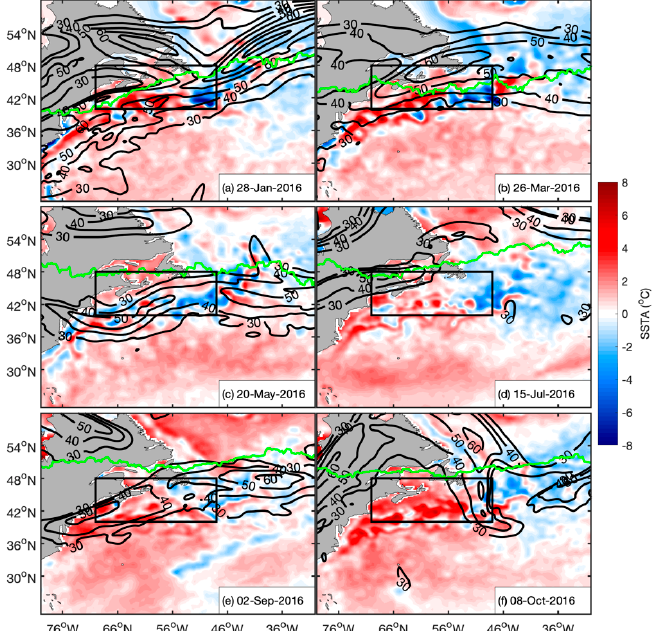
Figure 2. Spatial map of SSTA (°C) in the NW Atlantic throughout 2016. Black contour lines indicate wind speeds (m/s) at 300 hPa and the location of the Jet Stream. Green lines show the mean Jet Stream position based on the daily wind speed at 300 hPa from 1981–2020. Time series data was averaged over 40–48°N and 70–68°W indicated by the box. The 2016 MHWs were much less intense than the 2012 events. SSTAs were stronger in the earlier parts of the year (Figure 2a, average = 0.65 °C; Figure 2b, average = 0.32 °C) and later months (Figure 2e, average = 0.75 °C; Figure 2f, average = 1.62 °C). Positive SSTAs were contained closer to the coastline and southward where the Gulf Stream likely plays a role, while negative SSTAs were north and to the east most noticeably seen in early spring (Figure 2b) and mid–summer (Figure 2d, average = 0.20 °C). Figure 2c is the only exception where strong negative SSTAs follow the coast in the shelf region (average = 0.15 °C). The JS does not meander as in 2012 (Figure 1) or have a noticeable change from the climatological mean position, except in summer (Figure 2d) where the JS splits above the mean position.